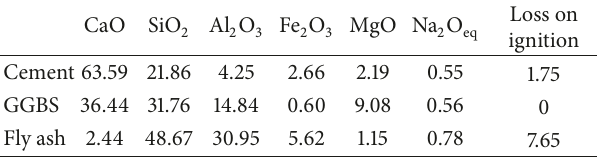
Table 1: Chemical compositions of cement, GGBS, and fly ash (%).